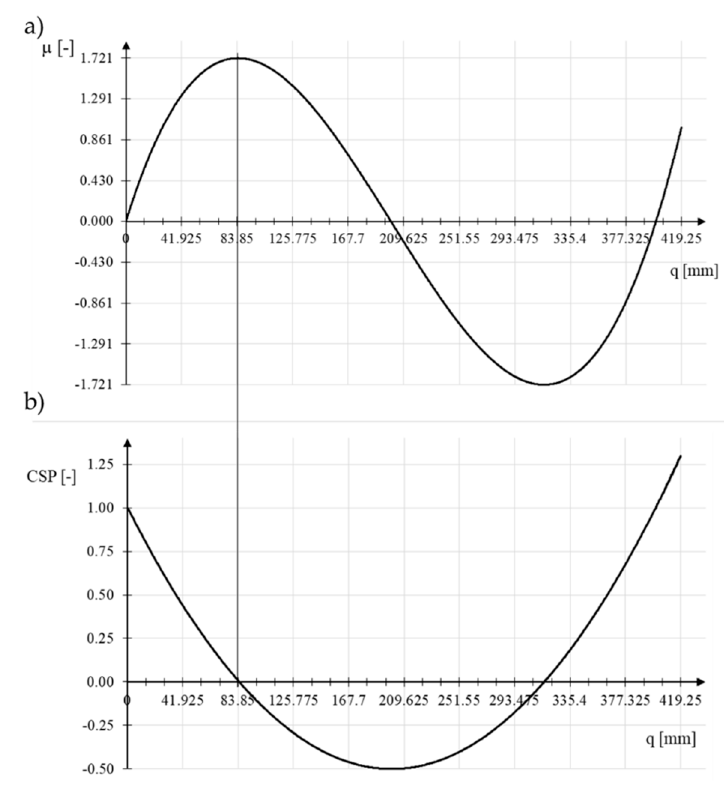
Figure 8. ( a ) Equilibrium path of shallow von Mises truss, ( b ) CSP-q path of shallow von Mises truss.